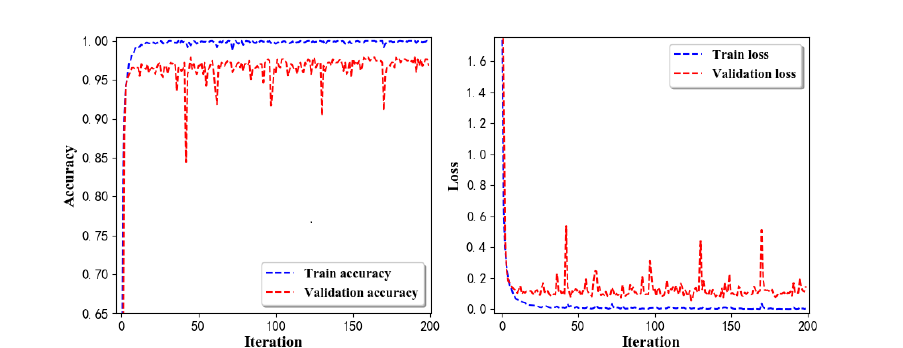
Figure 17. Accuracy ( left ) and loss ( right ) information of training and validation procedure.